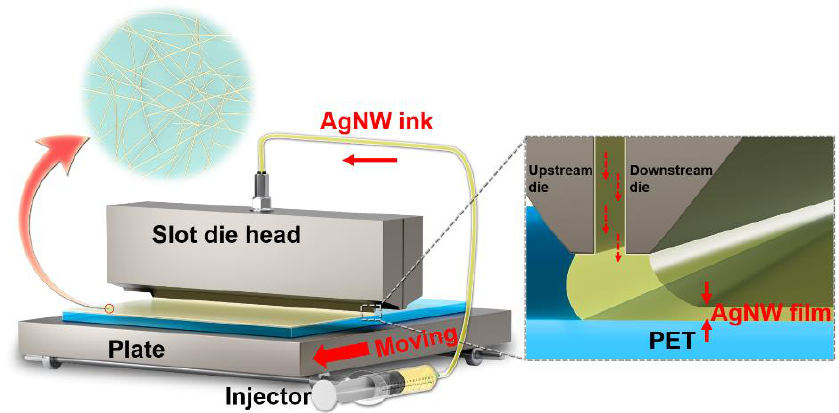
Figure 1. Schematic diagram of slot-die coating process of AgNW TCFs.